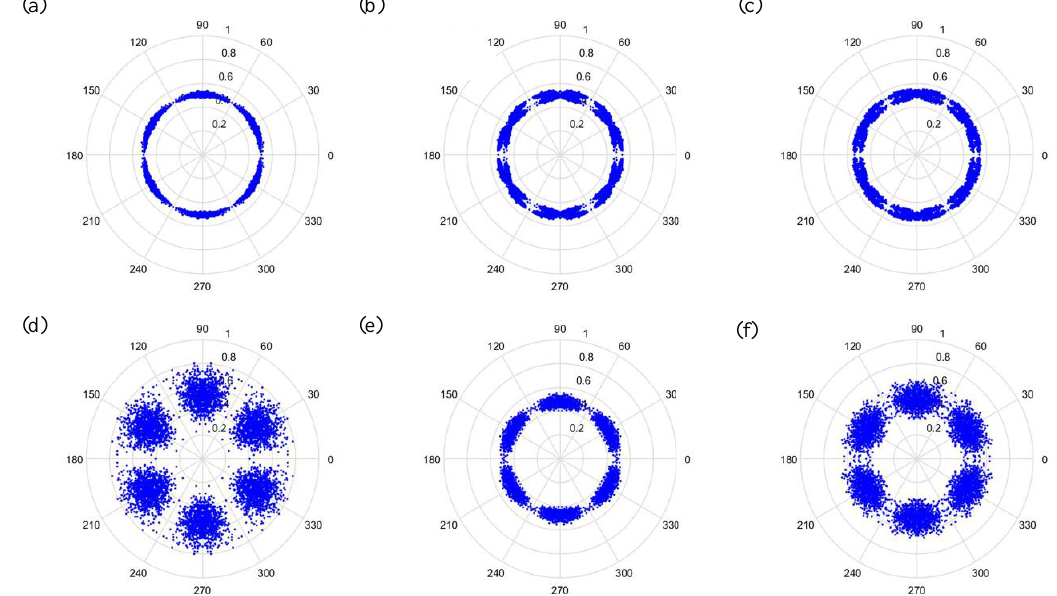
Figure 17. Results from improved formula when t = 1 and sampling is at 3000 Hz / 2000 rpm. ( a ) Normal, ( b ) motor platform with one eccentric screw, ( c ) motor platform with two eccentric screws, ( d ) sanded ball bearings, ( e ) insufficient lubrication, and ( f ) worn ball bearings.